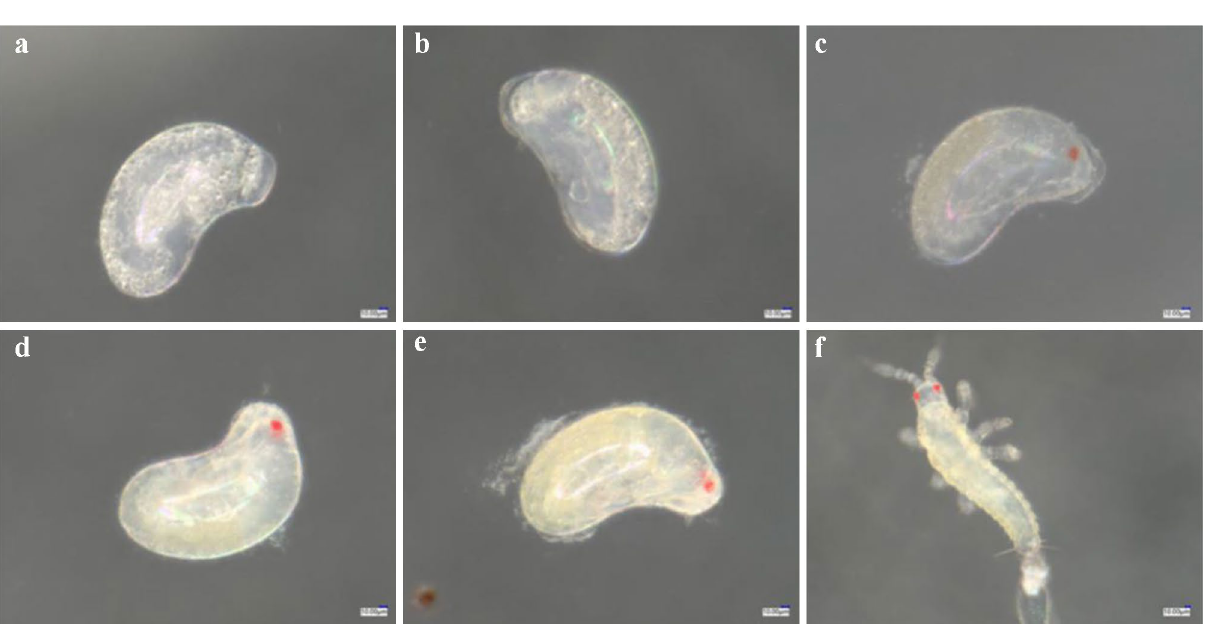
to spirotetramat decreased gradually. Frankliniella occidentalis are produced in plant tissues. In order to apply the treatment of isolated eggs to actual production conditions, this experiment was verified by a living plant method. The results showed the same trends for the live plant and egg dipping methods. Spirotetramat showed high toxicity, and the LC 50 value gradually decreased with increased egg age. However, the in vivo plant method resulted in a higher LC 50 than the egg dipping method, possibly due to material transportation and metabolism of the plant itself.